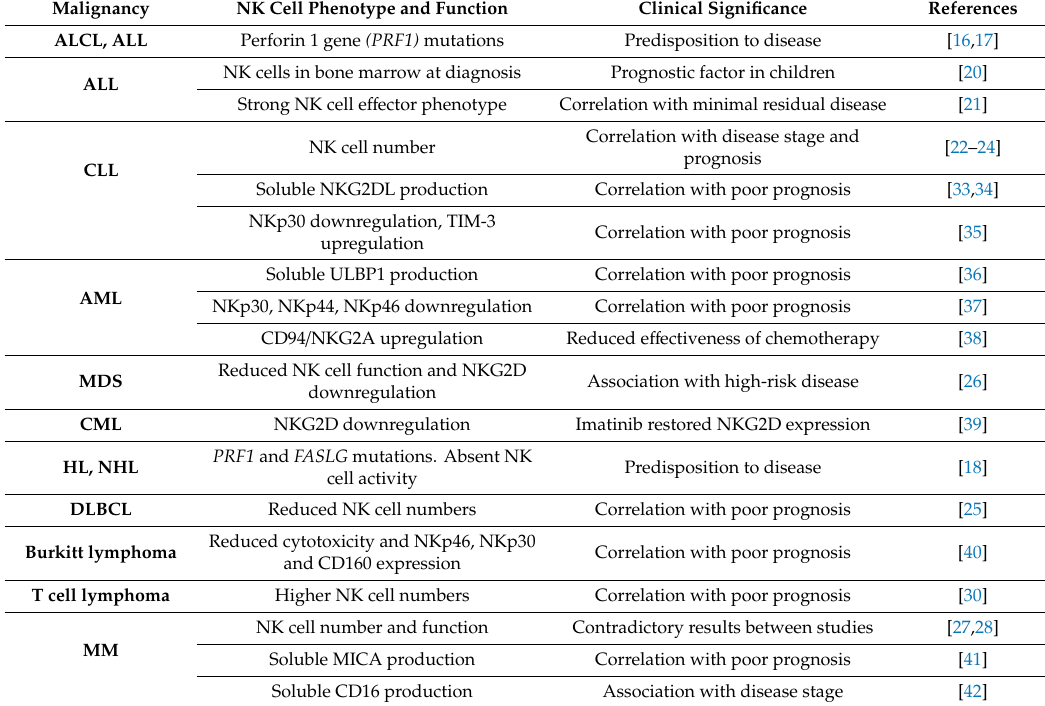
Table 1. Clinical implications and role of NK cells in the pathogenesis of hematological malignancies. ALCL, anaplastic large cell lymphoma; ALL, acute lymphoblastic leukemia; CLL, chronic lymphocytic leukemia; AML, acute myeloid leukemia; MDS, myelodysplastic syndrome; CML, chronic myeloid leukemia; HL, Hodgkin’s lymphoma; NHL, non-Hodgkin’s lymphoma; DLBCL, di ff use large B-cell lymphoma; MM, multiple myeloma; NK, natural killer; PRF1, perforin 1 gene; NKG2D, natural killer group 2D; NKG2DL, NKG2D ligands; NKp30, 44, 46, natural killer P30, 44, 46; TIM-3, T cell immunoglobulin domain, mucin domain; FASLG, Fas ligand gene; ULBP1, UL16 binding proteins